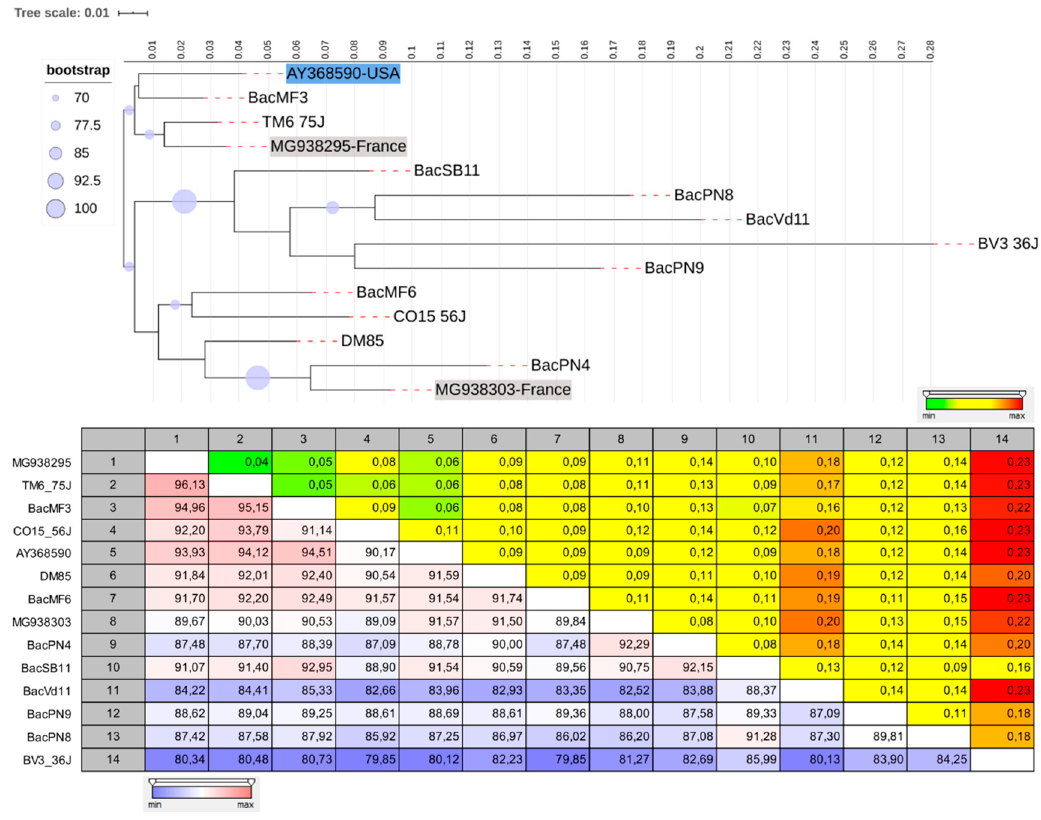
Figure 7. Maximum likelihood phylogenetic tree constructed from recovered consensus partial sequences of ( A ) grapevine leafroll-associated virus 2 (GLRaV-2) and full genome of ( C ) hop stunt viroid (HSVd). Neighbor-joining construction method with 1000 bootstrap replicates was used. Branch length represents phylogenetic distances determined with distance matrices of nucleotide sequences. Purple dots above critical branches are significant bootstrap values (>70%). GenBank accession number of fully sequenced genomes from different countries are highlighted for reference. Isolates from this study are represented and are not highlighted. The percent of identity (purple-red scale) and Jukes–Cantor distance (yellow-red scale) are presented for each pair of sequences of ( B ) GLRaV-2 and ( D ) HSVd. The percent of identity is the proportion of identical residues in the alignment positions to overlapping alignment positions between the two sequences. The distance was calculated using the Jukes–Cantor distance between the two sequences and is the proportion between identical and overlapping alignment position between two sequences. R package phylogram and the interactive tree of life platform were used to generate the tree (see the materials and methods section for more details).